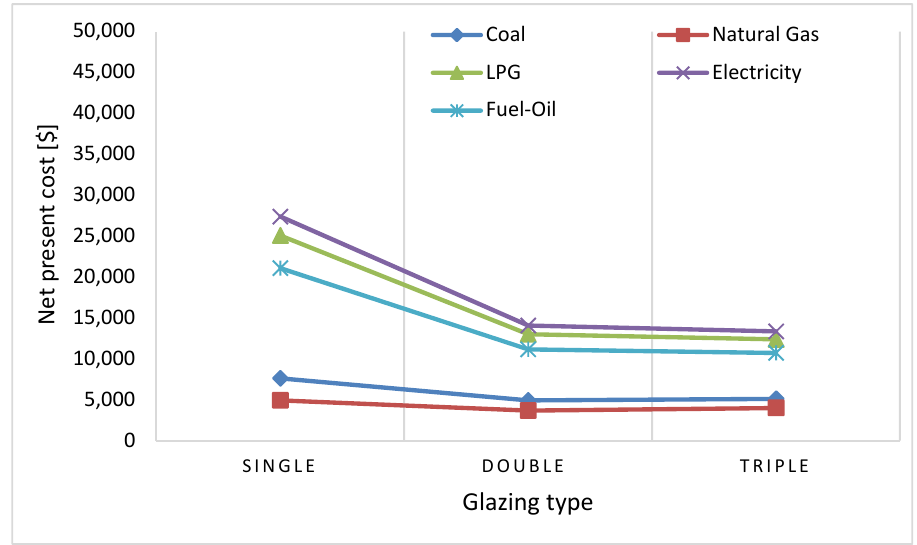
Figure 20. The influence of the fuel type on the net present cost for Istanbul.